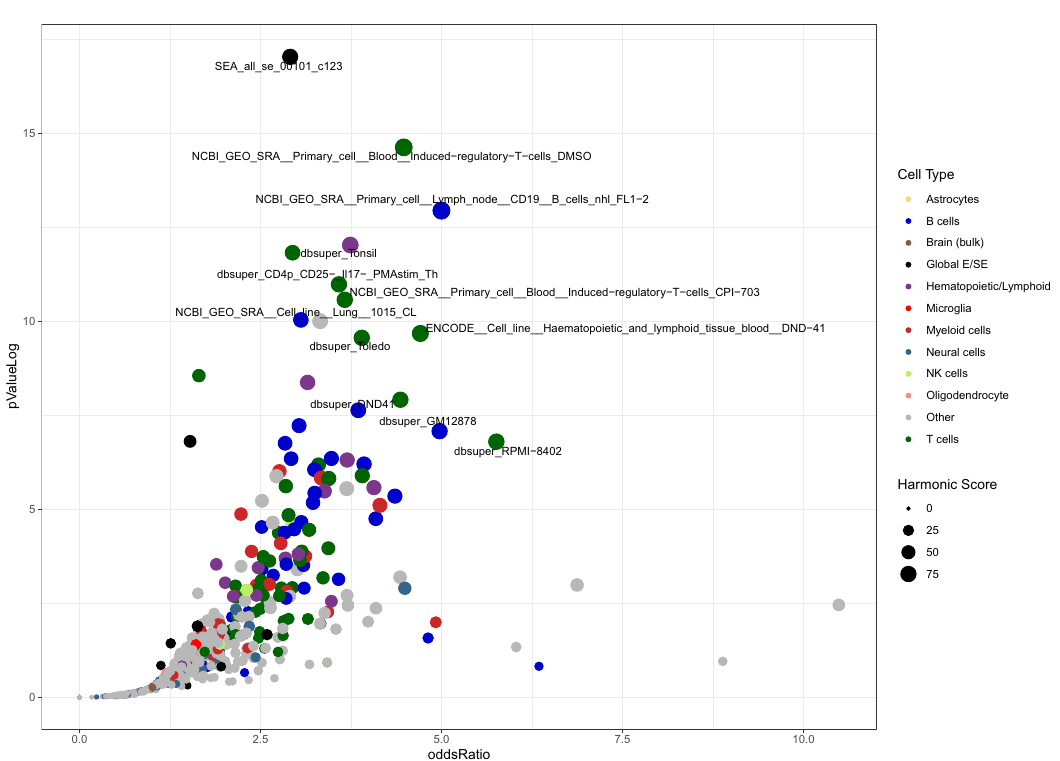
Figure 1. Enrichment of MS-associated SNPs in databases of regulatory elements, sorted by experiment/cell lines. X-axis shows the Odd Ratio, y-axis shows the − log ( p Value); dot size is proportional to to the Harmonic Score (HS), a comprehensive estimation of the relevance of hits, as derived by merging and balancing the OR, p Value and Support ( i.e., the number of hits resulting from the colocalization analysis) of each match. Thus, prioritized hits are represented by dots that occupy the upper-right area of the chart. Dots are coloured by cell type. Labeled points have HS > 50. Labels were arbitrarily designated according to the database of origin and the cell lineage where the enrichment occurred. Supplementary Table S4displays in detail the results that generated this